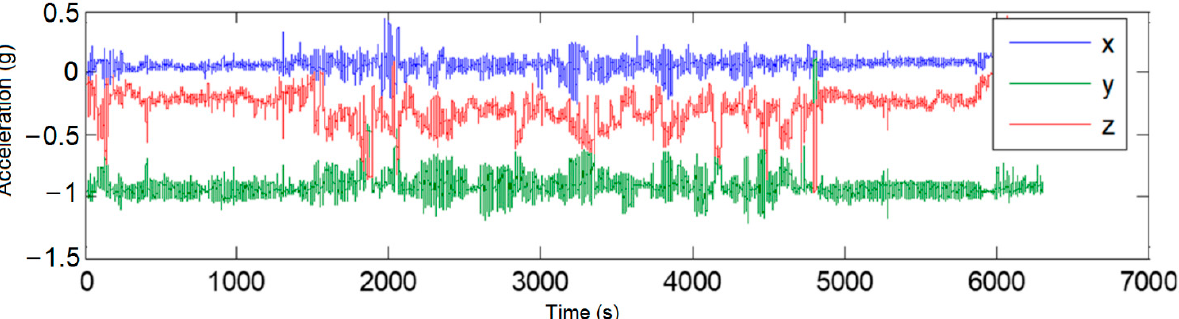
Figure 6. Diagram of Kalman filter.